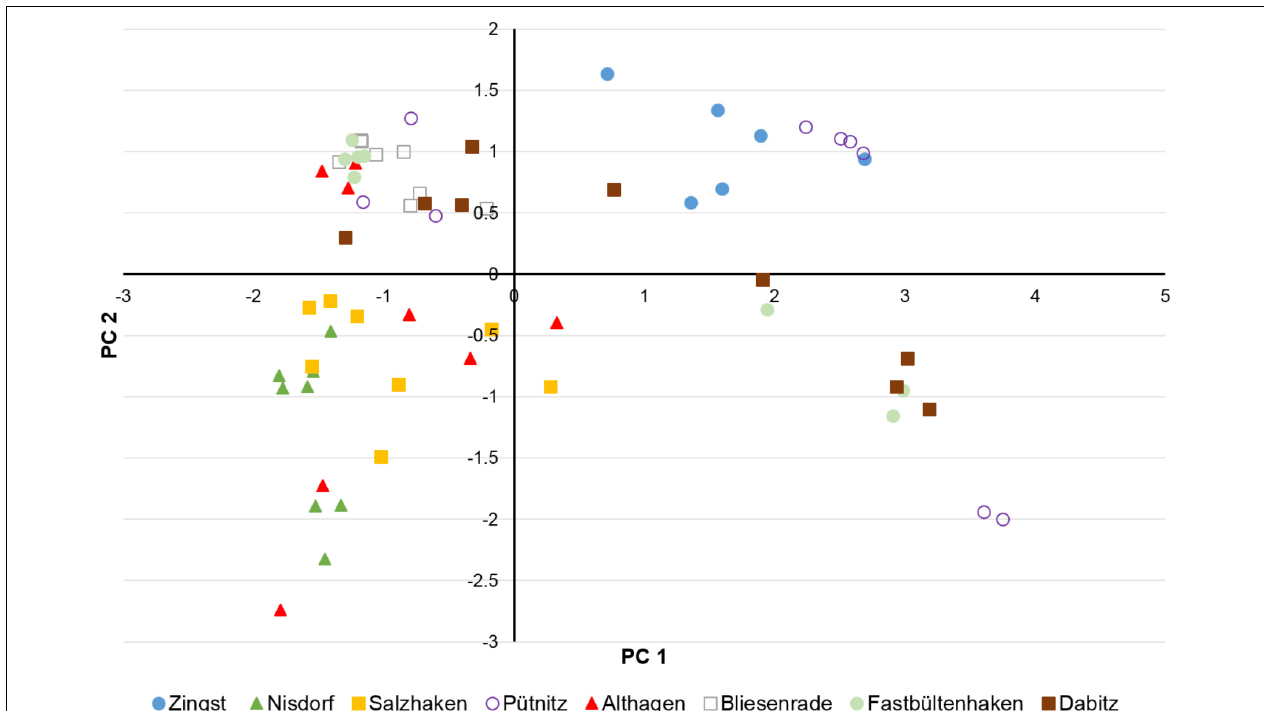
FIGURE 5 | Score plot of the principle component analysis (PCA) of water depth, DBD, concentration of LOI and TP and TP stocks in the first cm of the sediment samples of the transects near Zingst, Nisdorf, Salzhaken, Pütnitz, Althagen, Bliesenrade, Fastbültenhaken, and Dabitz.